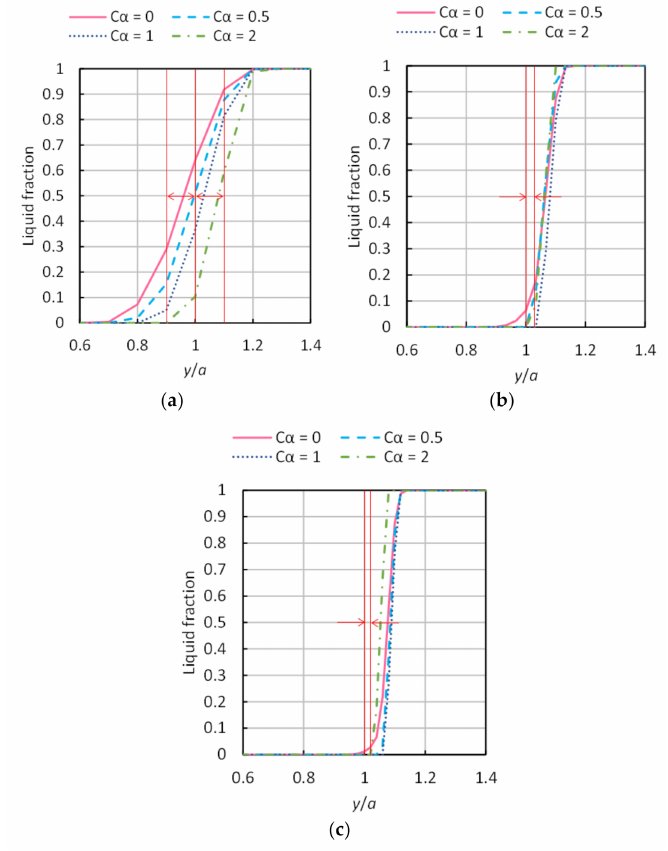
Figure 9. Liquid fractions near the upper disturbed interface for different interface compression (IC) (cid:0) (cid:1) = a / U g coefficients ( C α ) at t / 15 for x / a = 15 ( We g = 2): ( a ) 0.5 cells/ A c , ( b ) 1.5 cells/ A c , and ( c ) 2.5 cells/ A c